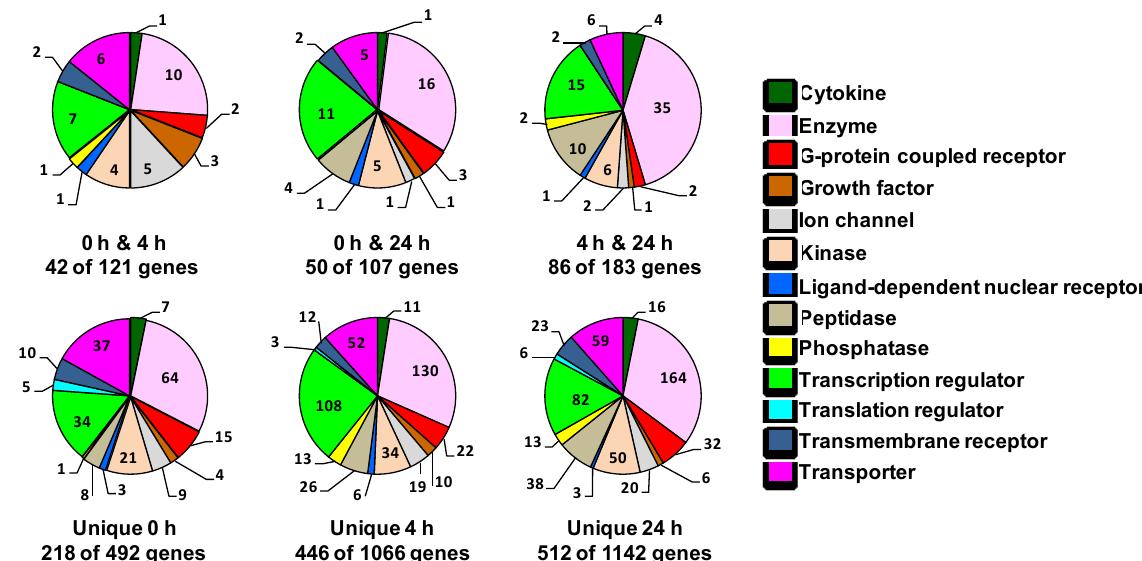
Figure 8. Gene family of the genes that are unique or are shared at two time points. The pie chart sectors represent the number of genes associated with each function indicated in the legend. The numbers of these genes are indicated for each function. The genes classified by IPA as “other” were not included in this representation. Genes were filtered for an absolute value log ratio  1.5 and a significance value of p ≤ 2